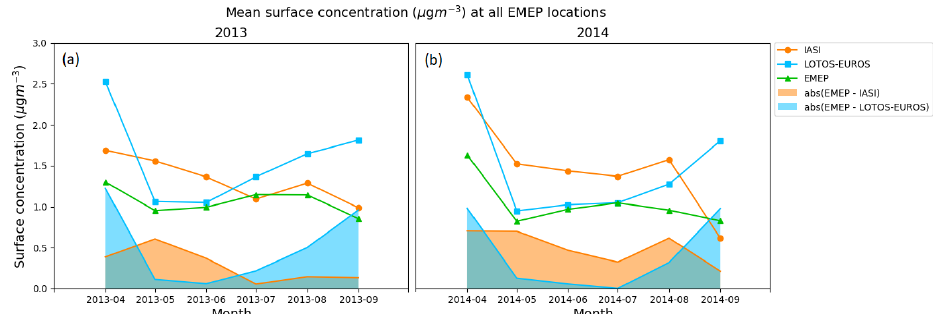
Figure 5. Mean of the NH 3 surface concentrations at all EMEP locations per month (green line) and the coinciding NH 3 surface concen- trations from LOTOS-EUROS (blue line) and derived from IASI (orange line) in 2013 (a) and 2014 (b) . The absolute differences between EMEP and LOTOS-EUROS are shown in blue and the absolute differences between EMEP and IASI are shown in